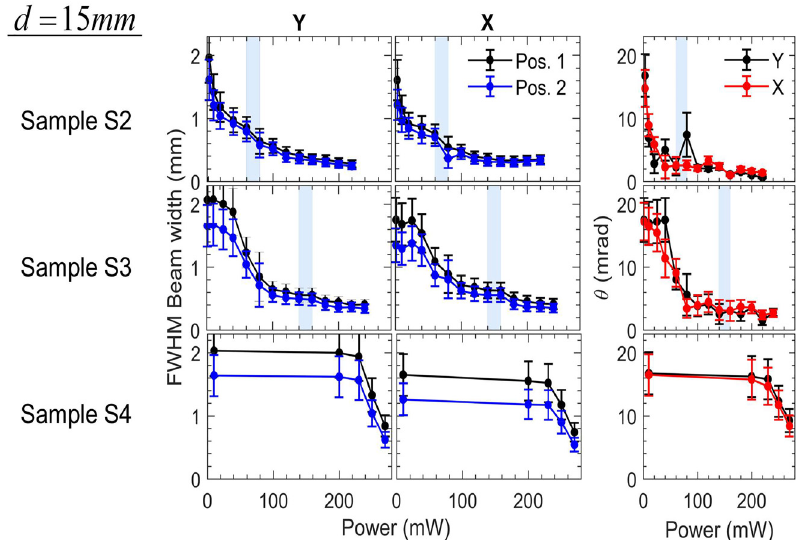
Figure 3: Same as Figure 2, for the samples S2, S3 and S4 and for d = 15 mm.